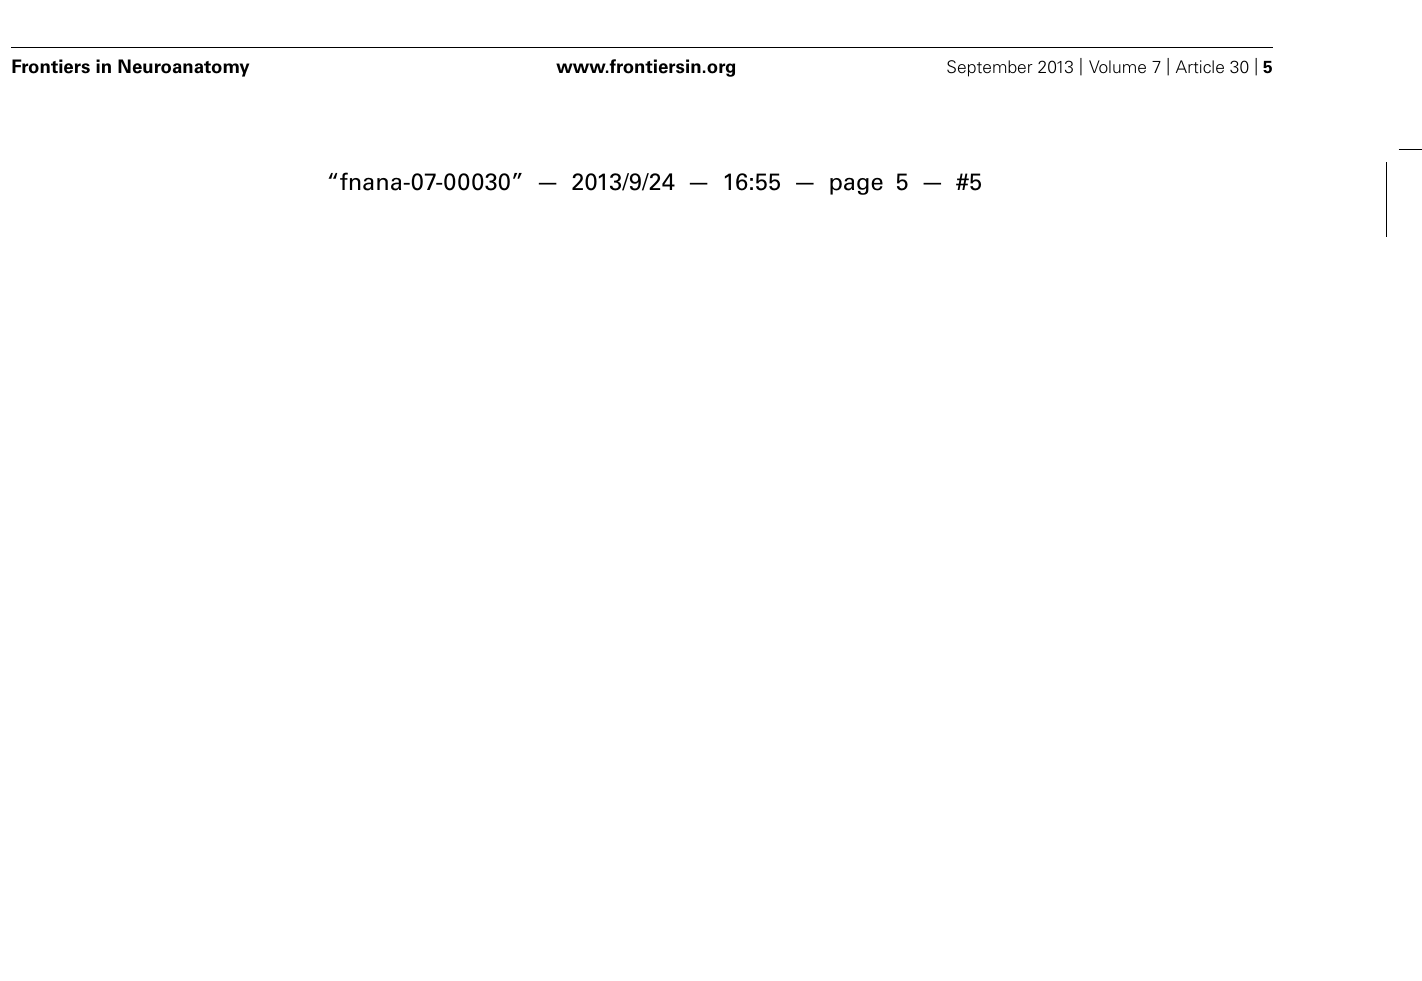
FIGURE 4 | Double-immunofluorescence labeling of representative thioflavin-S plaques and CR + neurites from preclinical AD (A,B), end-stage AD (D,E), APP/PS1 (G,H), and Tg2576 (J,K) transgenic mice shows a relative paucity of swellings containing calretinin (arrows). Filled arrowheads indicate normal-appearing CR neurites in association